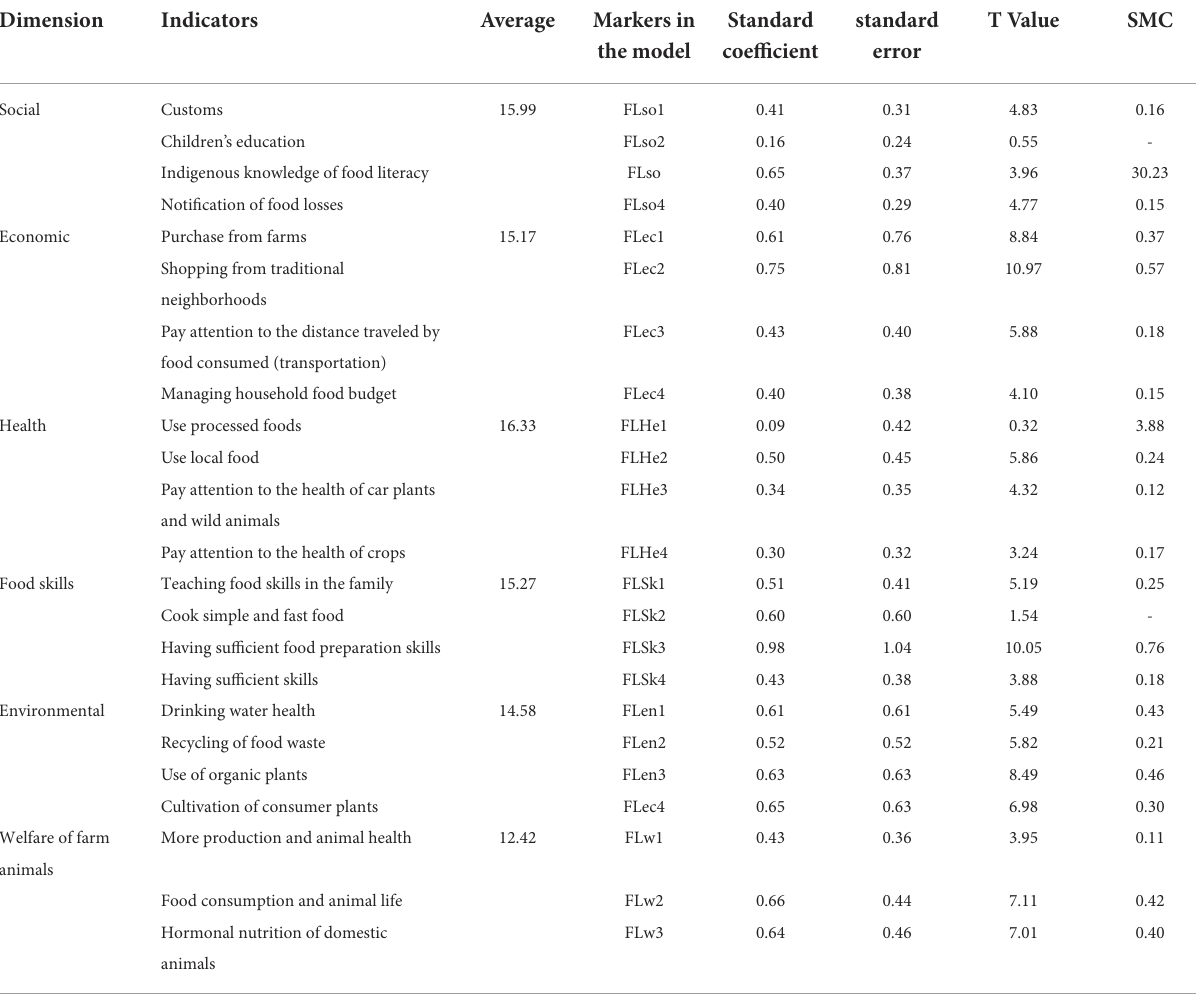
TABLE 7 Summary of results of food literacy measurement model (Second-order confirmatory factor analysis). Dimension